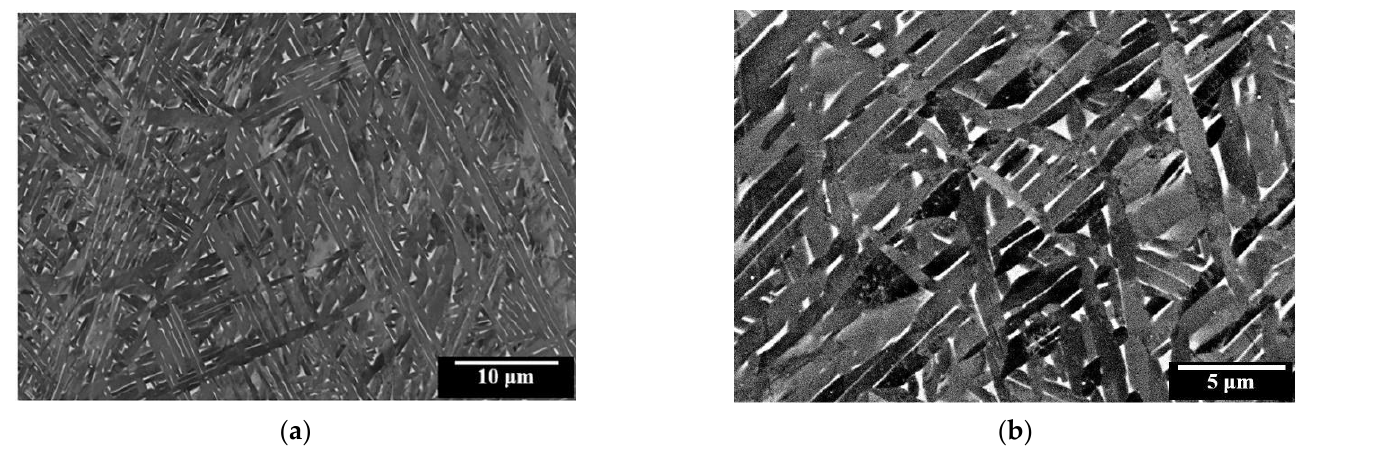
Figure 11. ( a ) Typical SEM micrograph of the heat-treated titanium femoral stem produced via DPF showing the α + β lamella microstructure; ( b ) Higher magnification showing the fine lamella morphology. Table 4. Average HRC hardness of the as-forged and heat-treated conditions for each region of in- terest of the Ti-6Al-4V DPF ELI hip component.